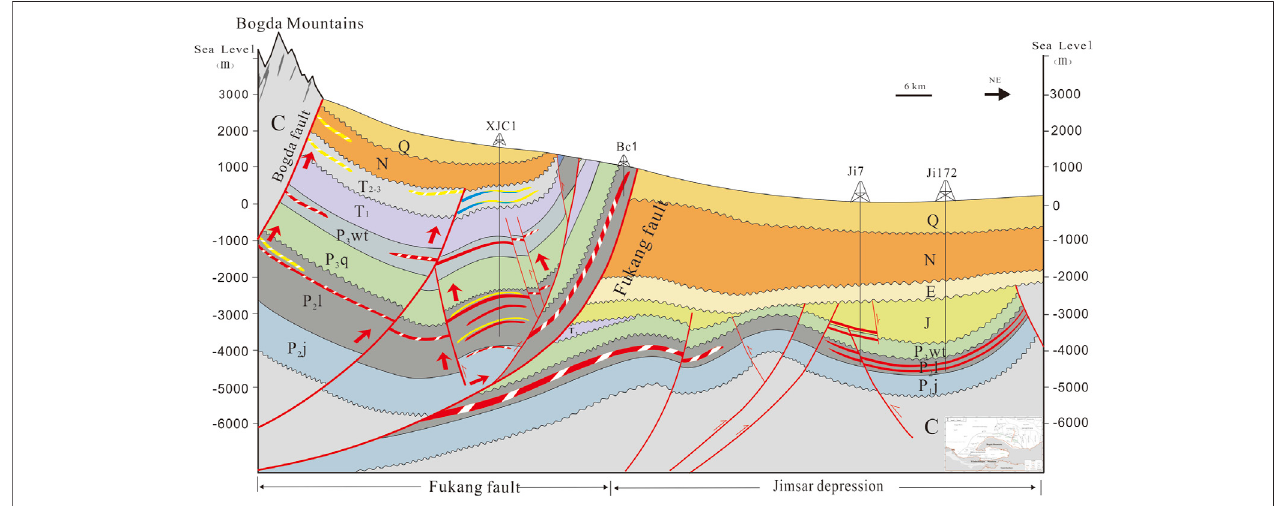
FIGURE 11 | Petroleum accumulation and fi lling model through well XJC 1 of Fukang fault zone (the cross-well pro fi le line is indicated as the red line in Figure 1 ).